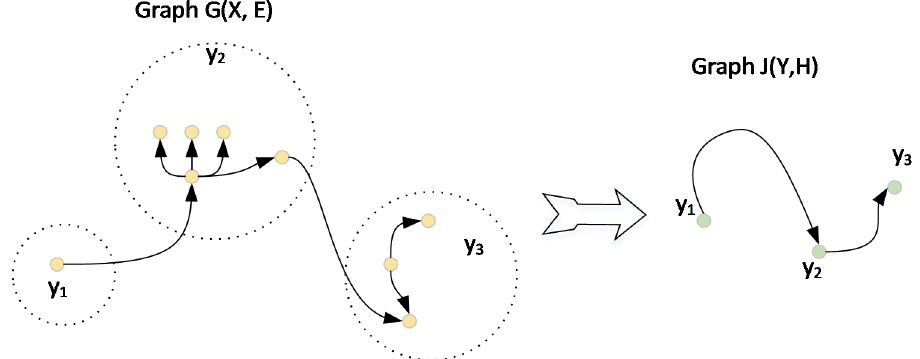
Figure 2. Graphs of I&C information model with subsystem hierarchy ( left ) and without it ( right ).